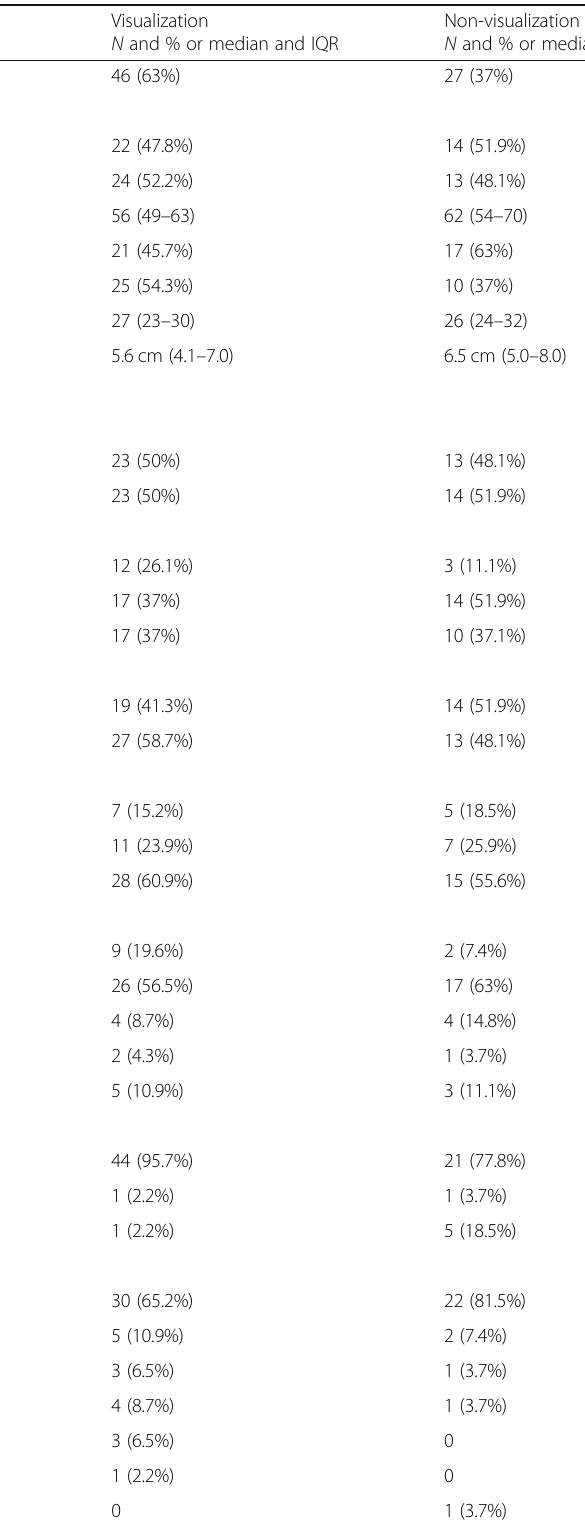
Table 2 Patient and procedure characteristics for visualization and non-visualization